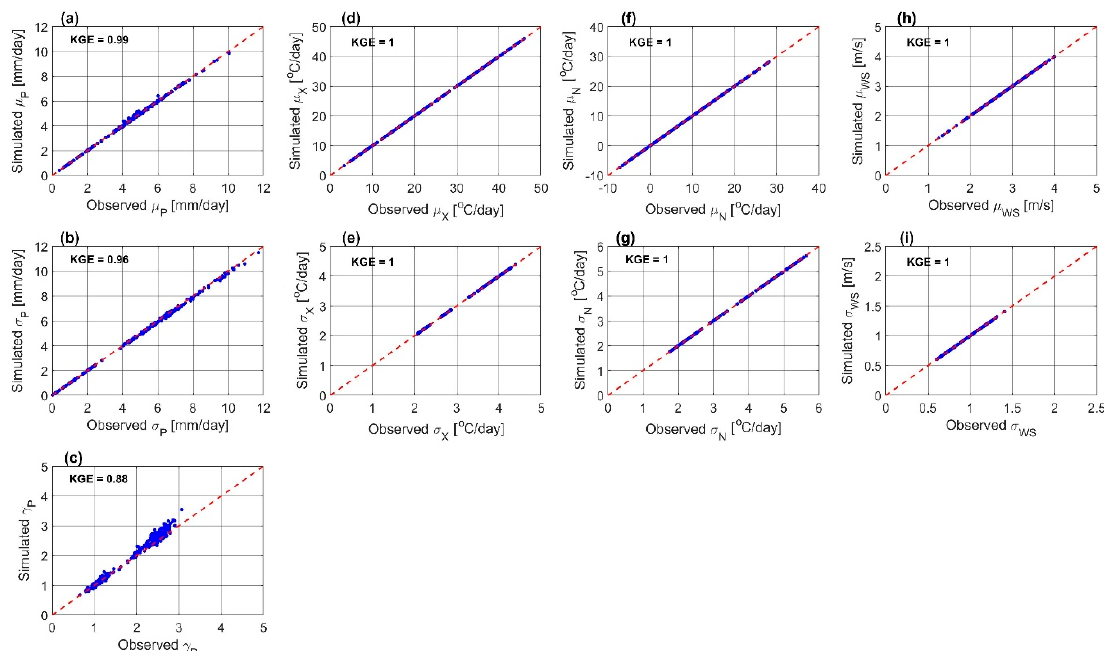
Figure 6. Comparisons of the daily statistic parameters of the observations and simulations. ( a – c ) are the mean, standard deviation, and skewness of P. ( d – g ) are the mean and standard deviation of T x and T N . ( h , i ) are the mean and standard deviation of the WS.